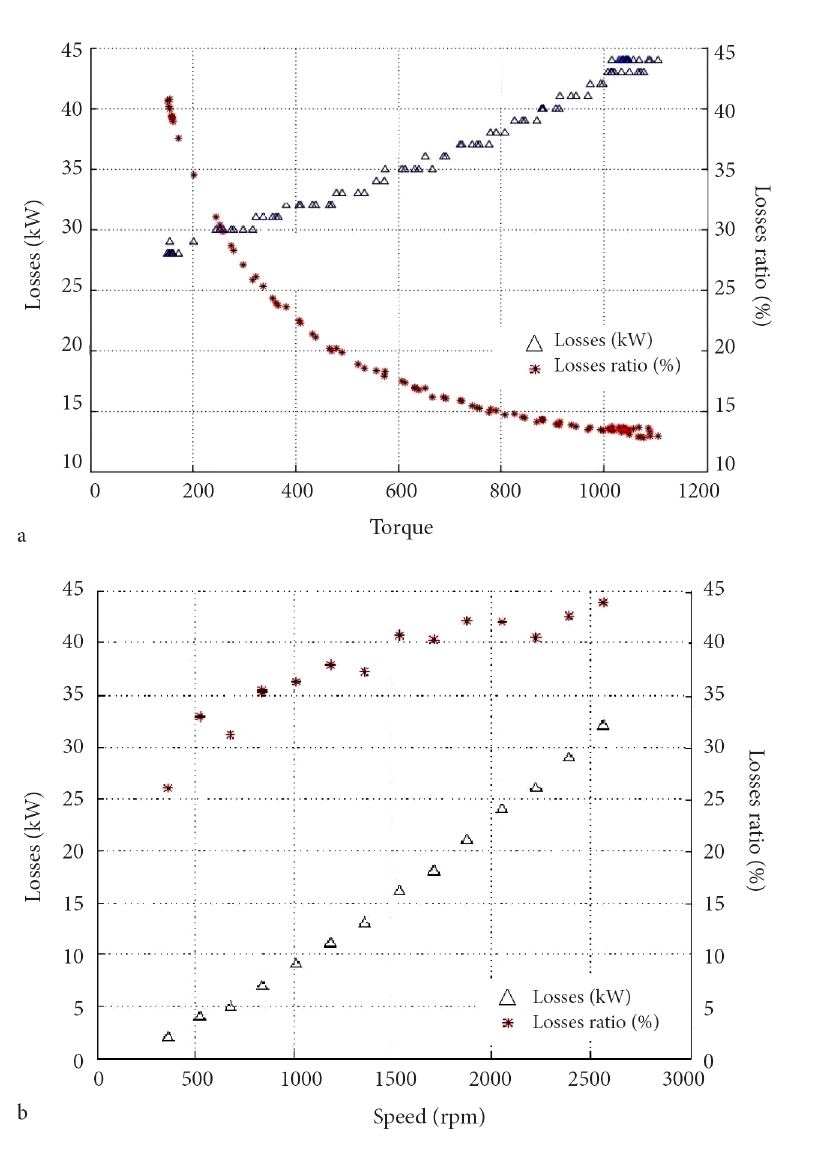
Fig. 15. a) Losses and loss ratio of the system with constant 3000 rpm speed and variable torque; b) losses and loss ratio of the system with constant 150 N.m torque and variable